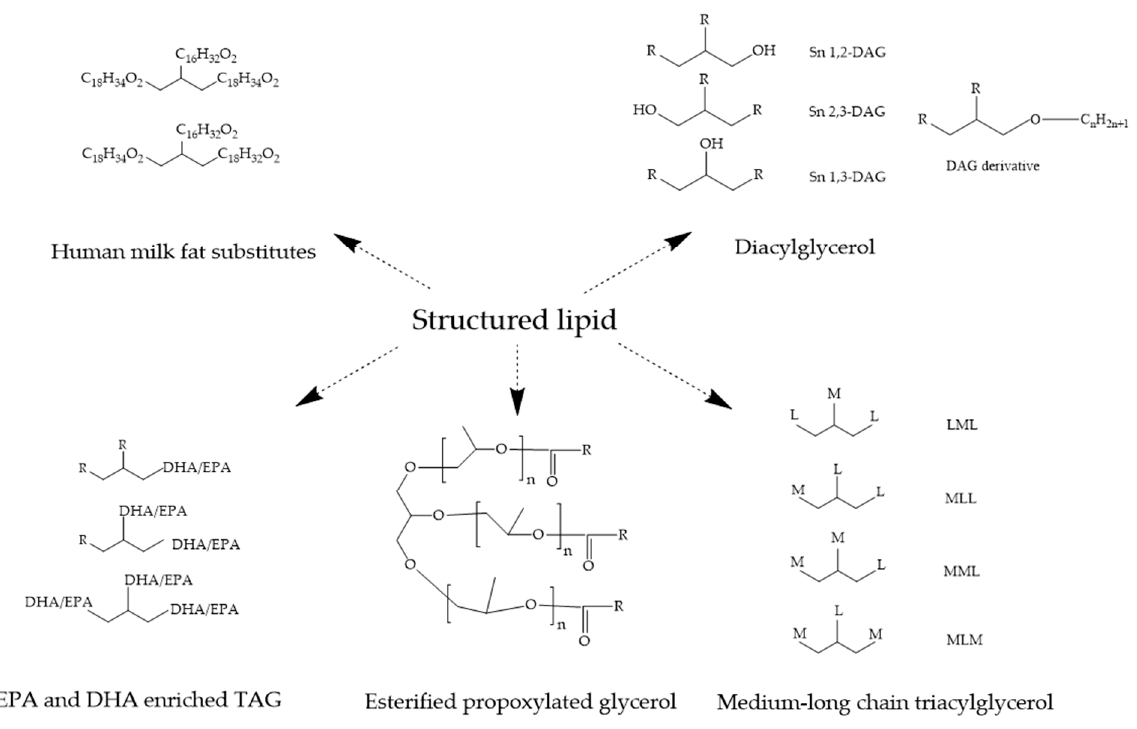
Figure 1. The structure of five structured lipids. (R, M, L, C 18 C 34 O 2 , C 16 H 32 O 2 , and C 18 H 32 O 2 represent fatty acids, medium-chain fatty acids, long-chain fatty acids, oleic acid, palmitic acid, and linoleic acid, respectively).